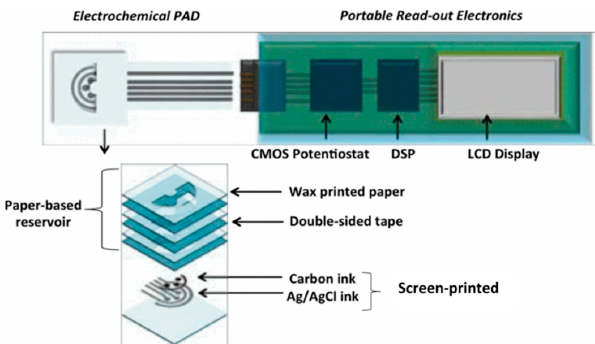
Figure 10. 3D electrochemical origami paper ‐ based analytical device (omPAD) integrated with a custom CMOS potentiostat (Adapted with the permission from IEEE) [67].